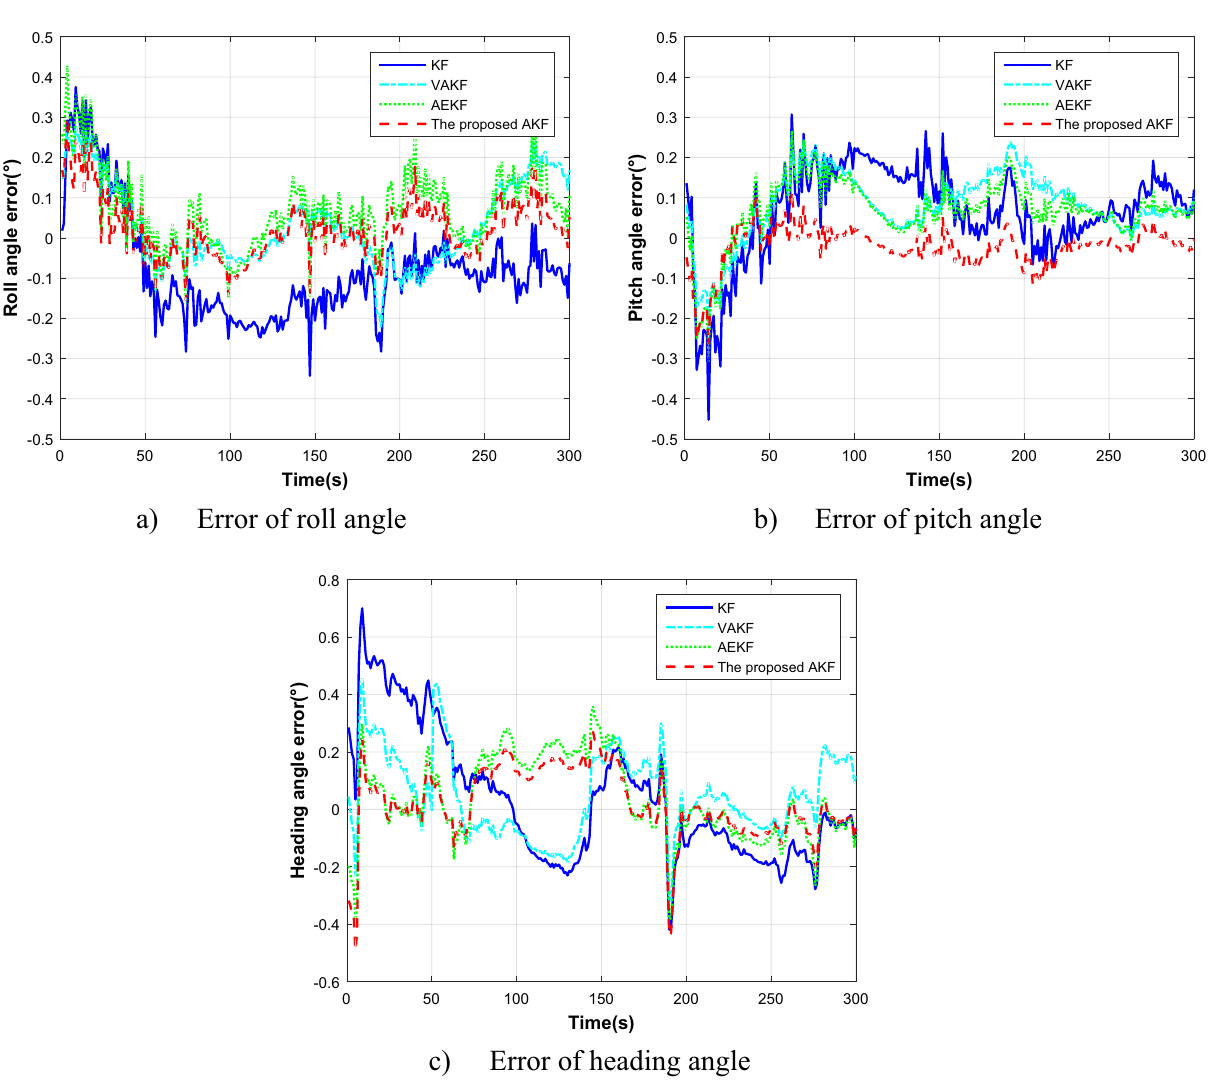
Figure 7. The alignment estimation error comparison in the accelerated linear motion.